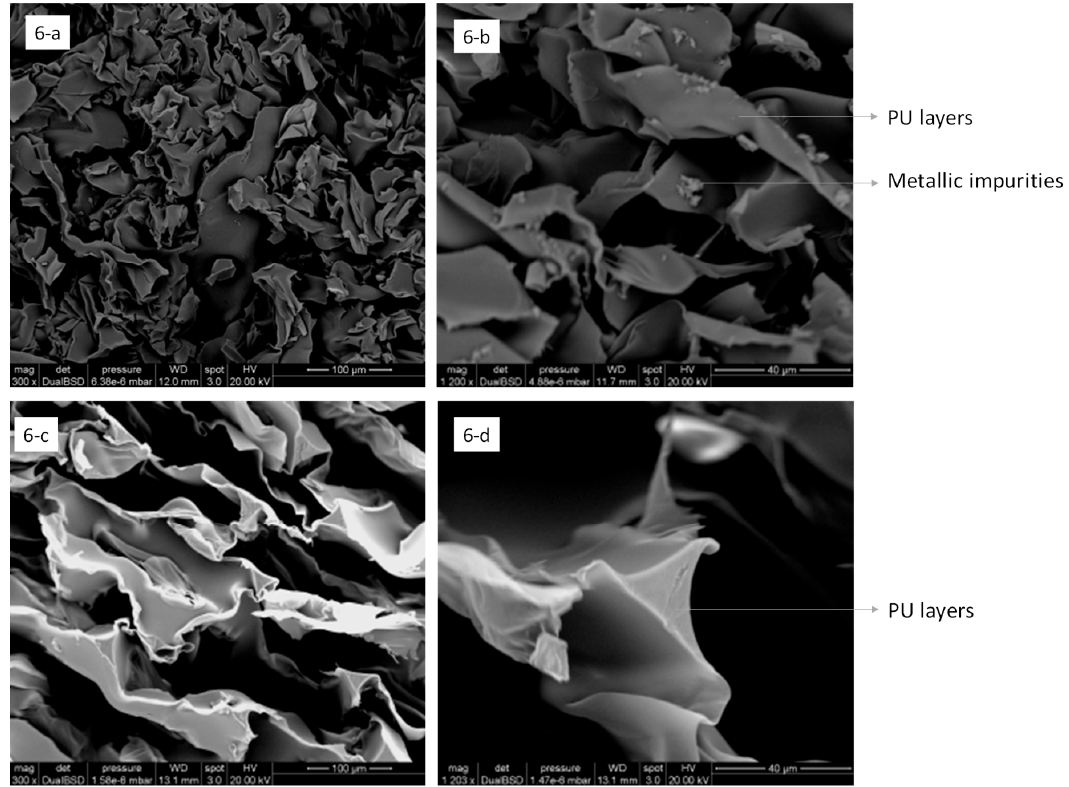
Figure 6. ( a , b ) Microstructure of the PU waste (P) and ( c , d ) PU waste (A) by SEM.